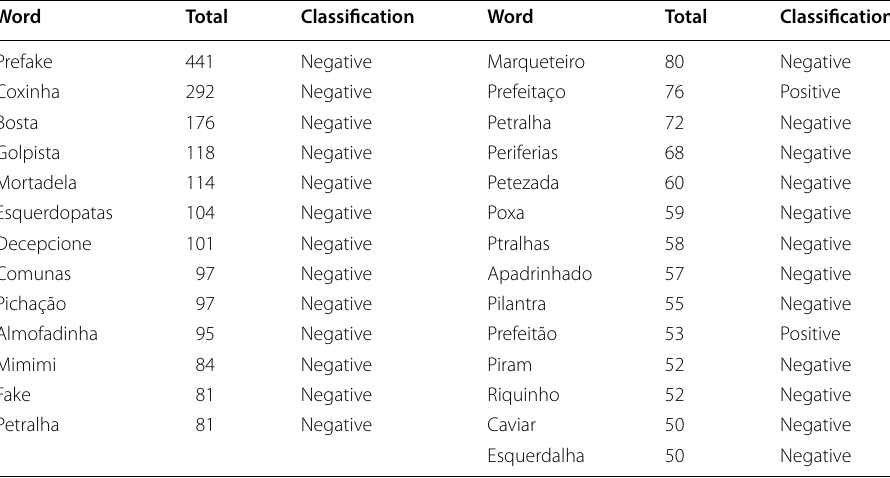
Table 1 Analysis of unknown words in formal language. Source: prepared by the author Word Total